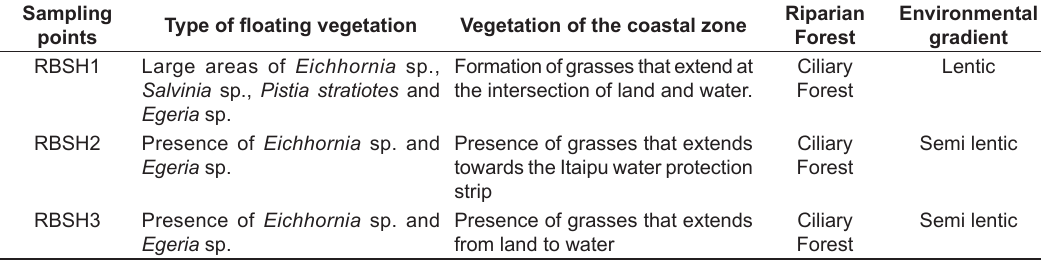
Table 1. Physiographic characteristics of the sampling points around Refúgio Biológico de Santa Helena, Itaipu Reservoir, Paraná III River Basin, Brazil, in which, RBSH = Refúgio Biológico de Santa Helena. Sampling